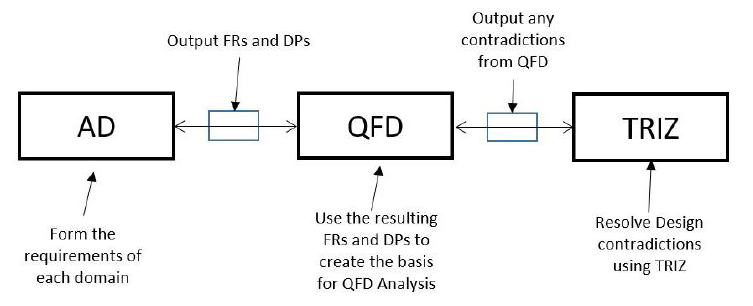
Figure 5. AD, QFD, and TRIZ Integration [30].